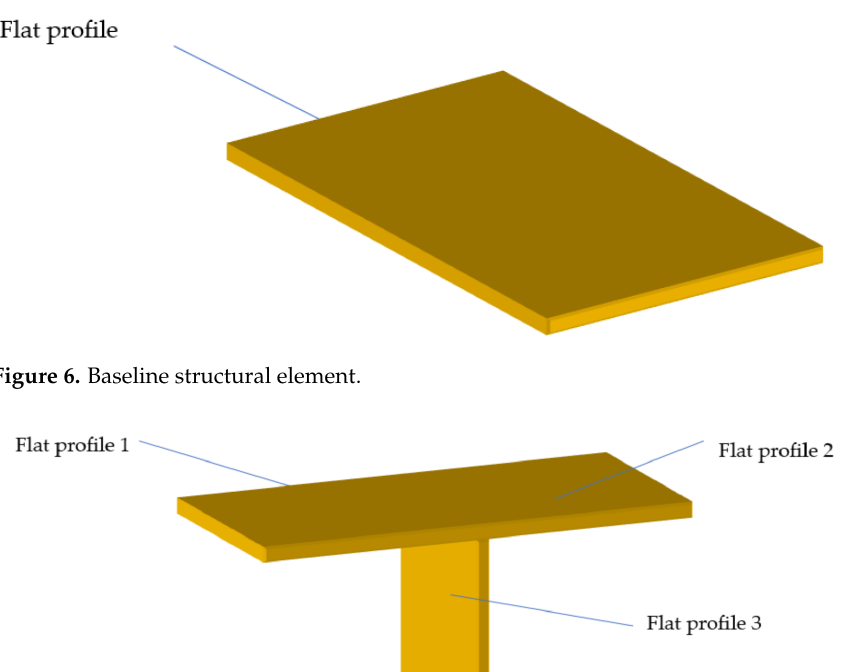
Figure 5. Unit cell, orthogonal 3D woven architecture: 7 warp layers, 8 weft layers, 28 fibre ends per unit cell, and 5 warp binder ends.